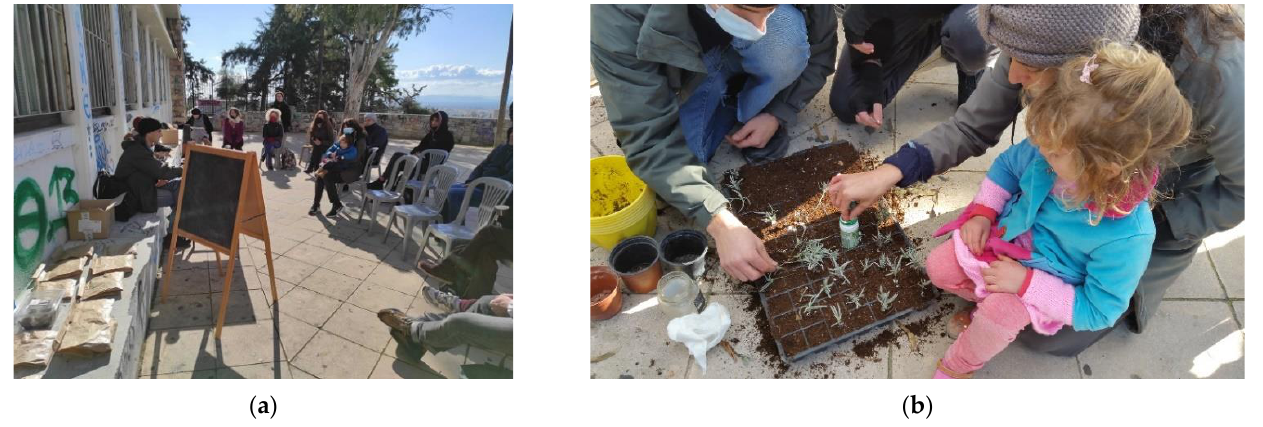
Figure 5. A seed exchange and germinating techniques seminar at the terrace ( a ) and planting seedlings by the workshop participants ( b ), 23 January 2021. (Photo credit: Monica Vaxevani).